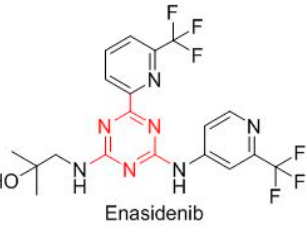
Figure 7. Structure of enasidenib that contains the triazine (in red) scaffold.